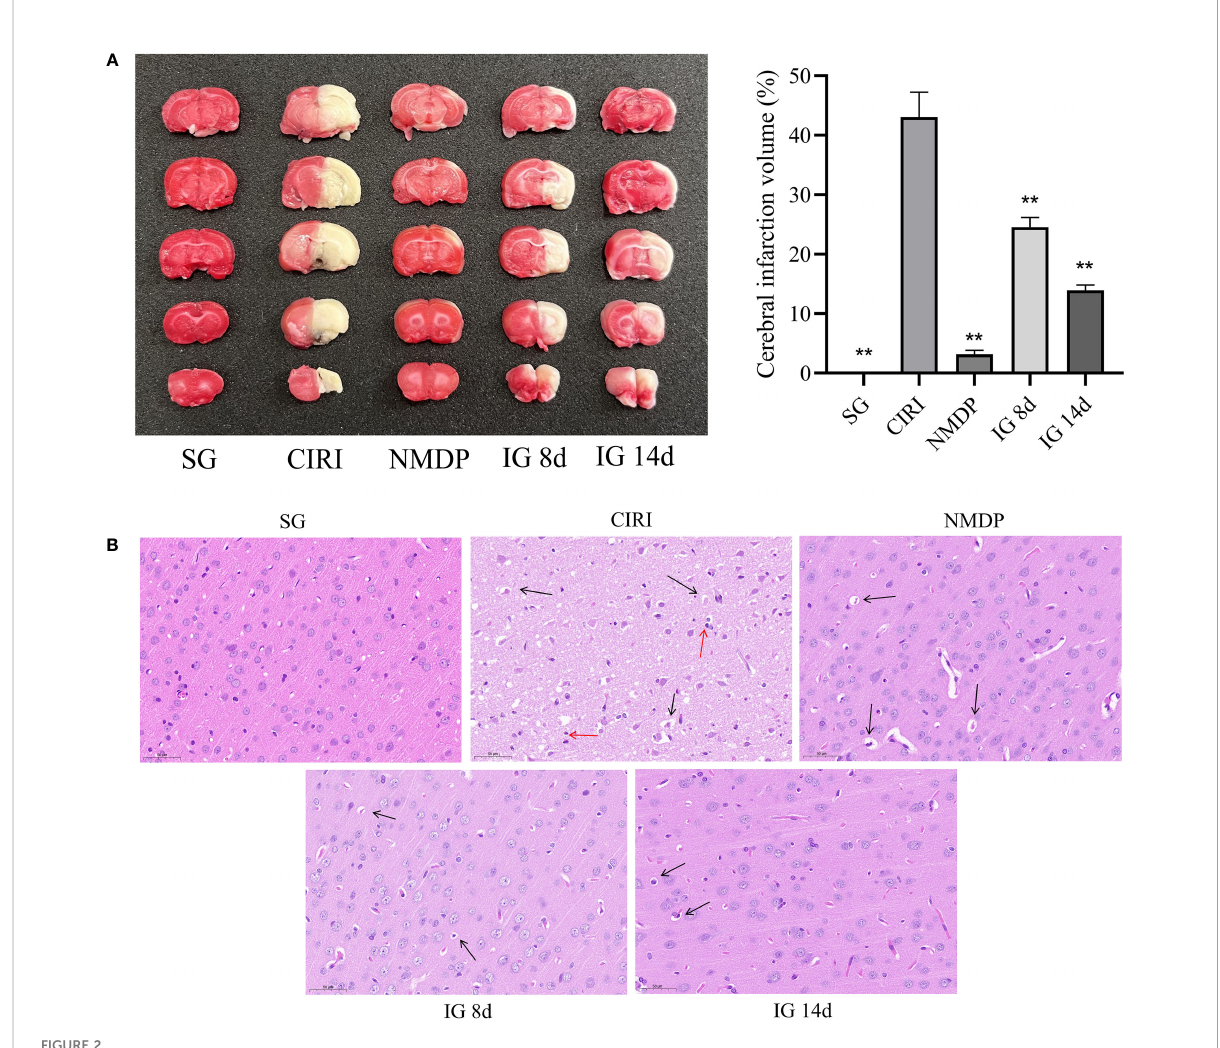
FIGURE 2 (A) Images of the brain by 2,3,5-triphenyltetrazolium chloride (TTC) staining (left). Quanti fi ed data of TTC staining presented in ischemia volume (%) (right). ** P < 0.01. (B) Brain tissue sections of rats in each group. Black arrows mean vacuoles, and red arrows mean in fl ammatory cell in fi